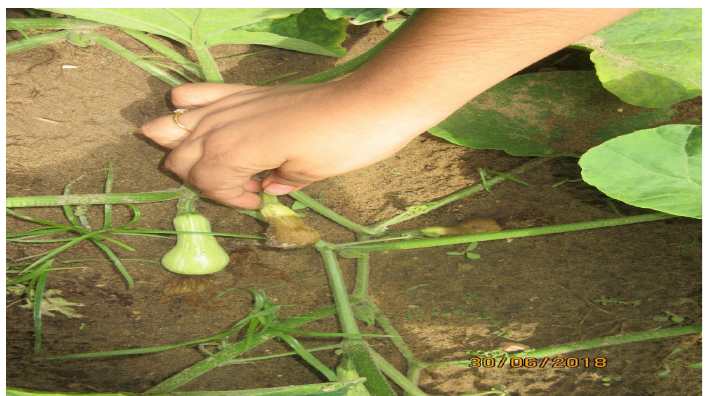
Figure 2: Fruit rot symptoms in diseased butternut squash fruit under field condition. The fruit on the left is a healthy fruit, and two fruits on the right show characteristic rotting symptoms.